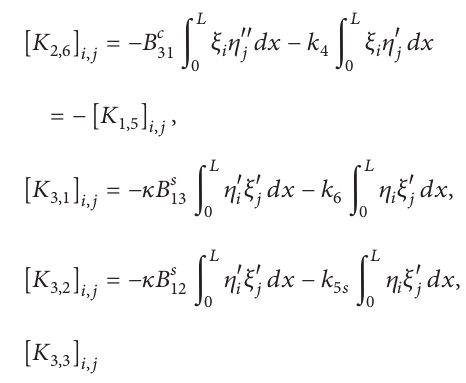
Figure 8: The first three natural frequencies versus rotating speed for various thicknesses of viscoelastic damping layer ( ℎ 𝑐 = 2 mm, 𝜃 = 60 ∘ ).